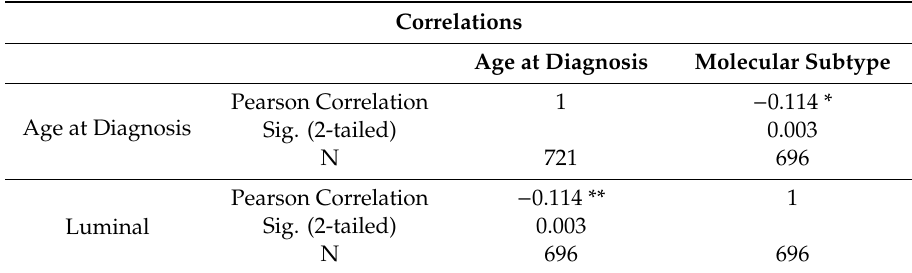
Table 3. Correlation between age at diagnosis and molecular